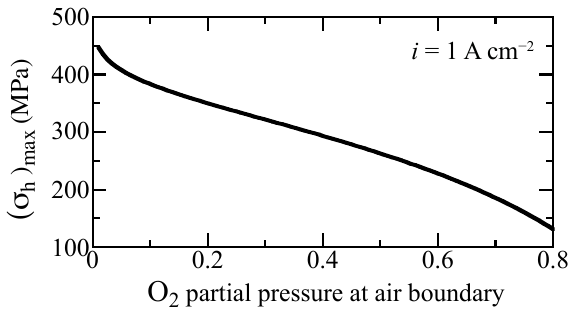
Figure 10. Maximum hydrostatic stress as a function of oxygen fraction at the outer boundary under i = 1 A cm − 2 imposed current density. The oxygen fraction is balanced with steam. The cell is fixed at a temperature of 600 ◦